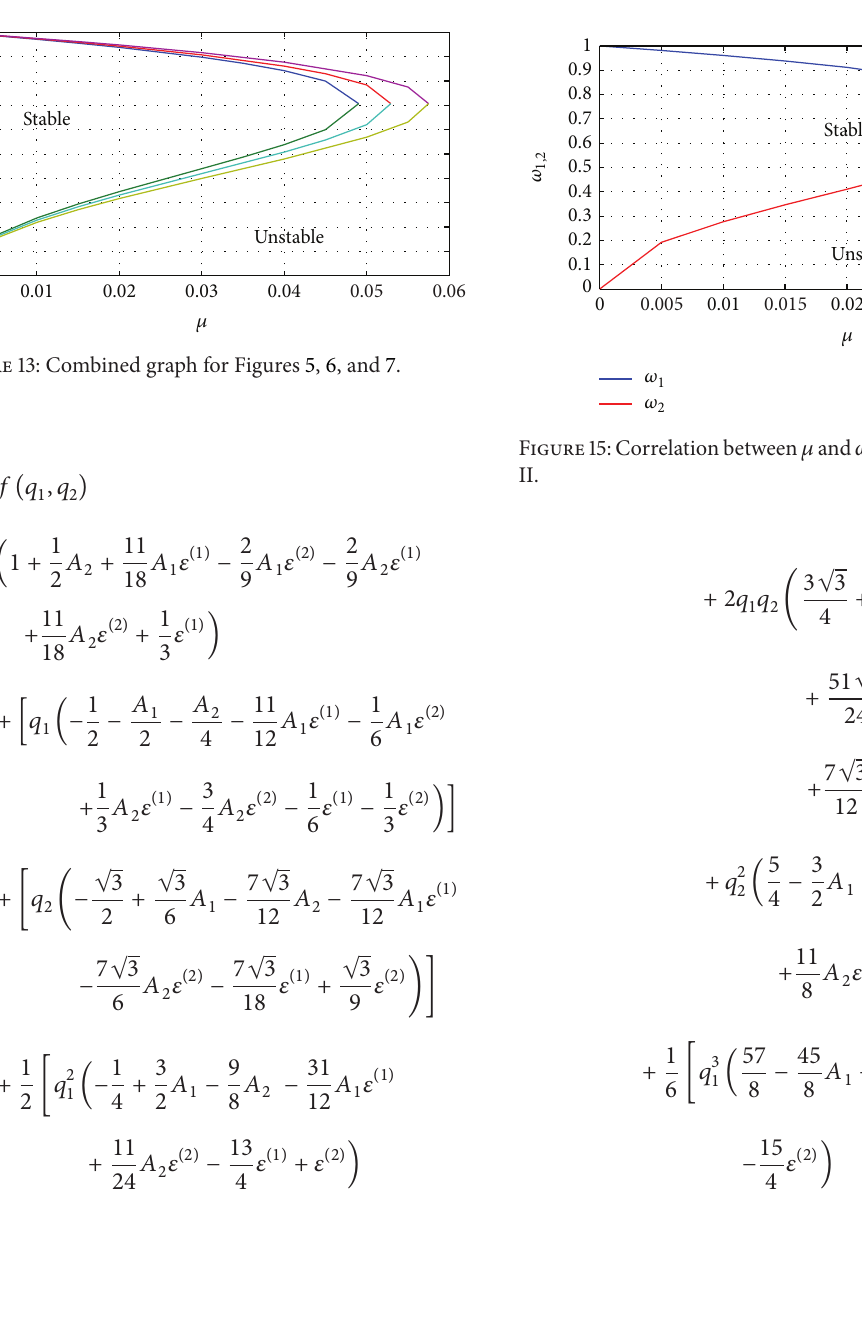
Figure 15: Correlation between 𝜇 and 𝜔 1,2 for binary system Achird-